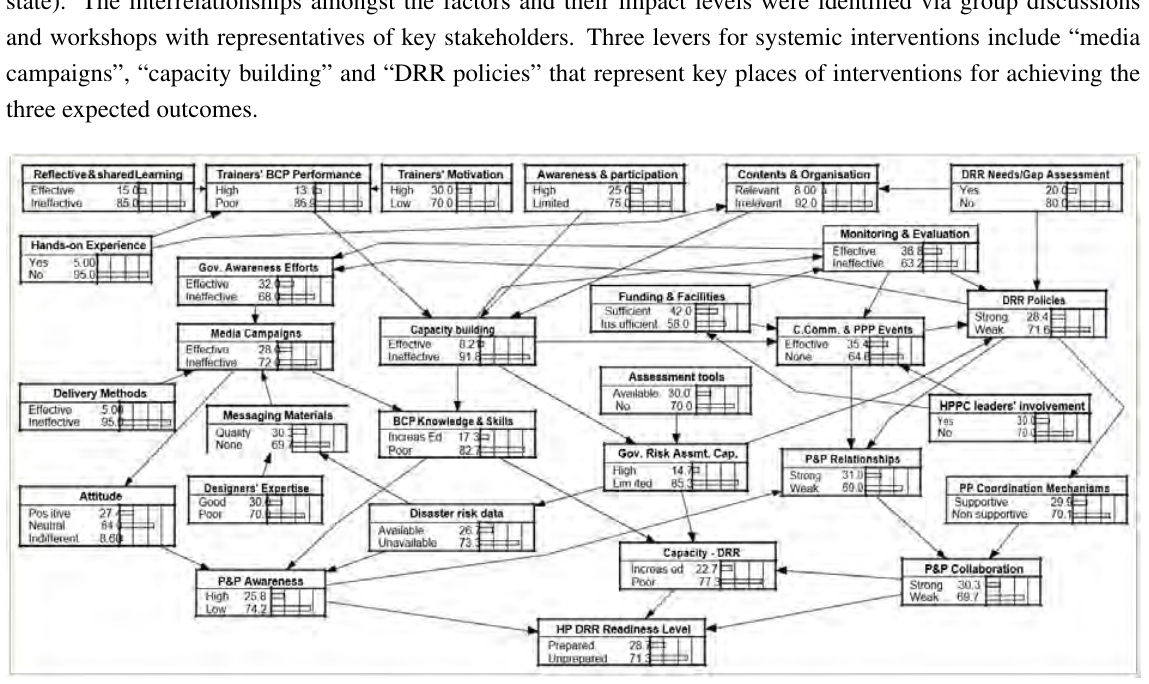
Figure 2. Bayesian Belief Network (BBN) model for the current situation of disaster risk management in Haiphong. Notes: Yellow variable represents the final goal; Green variables represent sub-goals (expected outcomes); Red variables represent leverage points for systemic interventions; Dark variables represent systemic